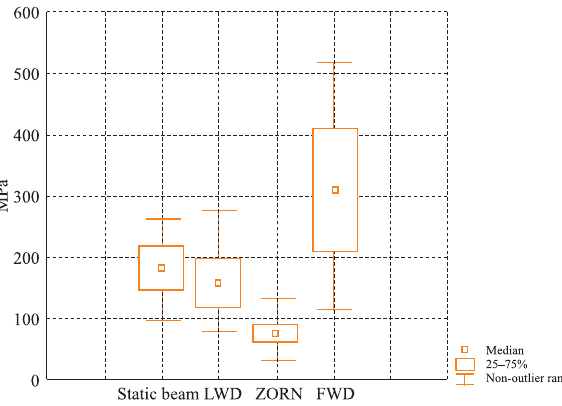
Fig. 2. Dispersion plot of measuring results on the subgrade (left side)